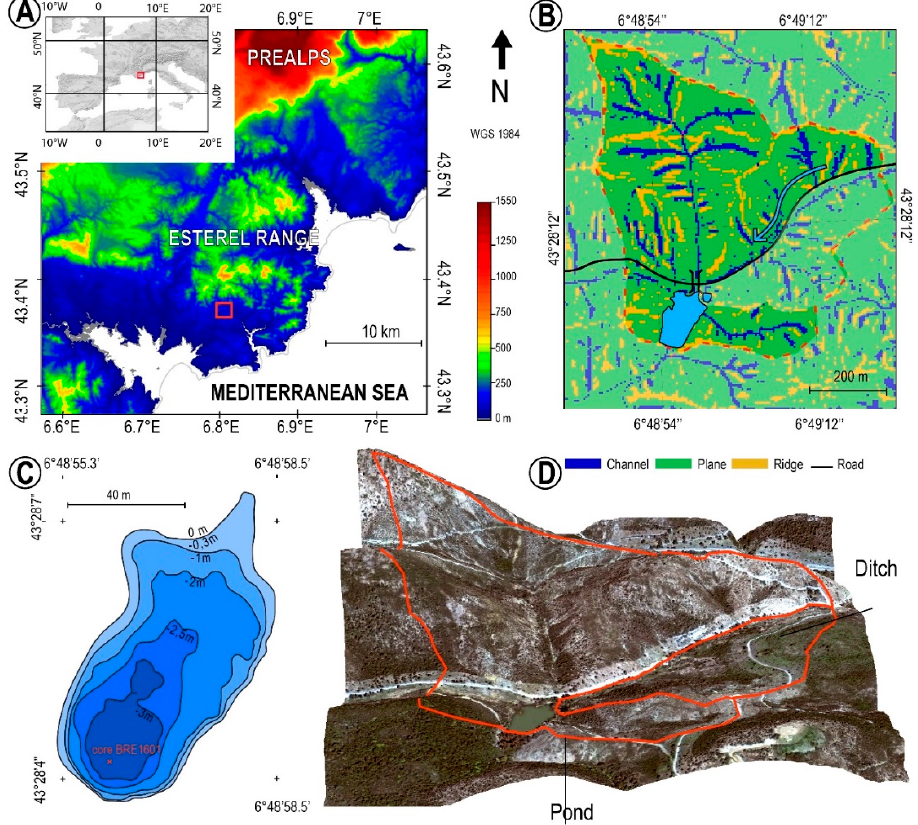
Figure 1. ( A ) Location of the site in the Esterel Massif. ( B ) Classification of the watershed topography of the lake. ( C ) Bathymetry of the lake with the coring site. ( D ) Numerical model of the catchment area and the subwatershed drained by the pond located northeast of the lake.